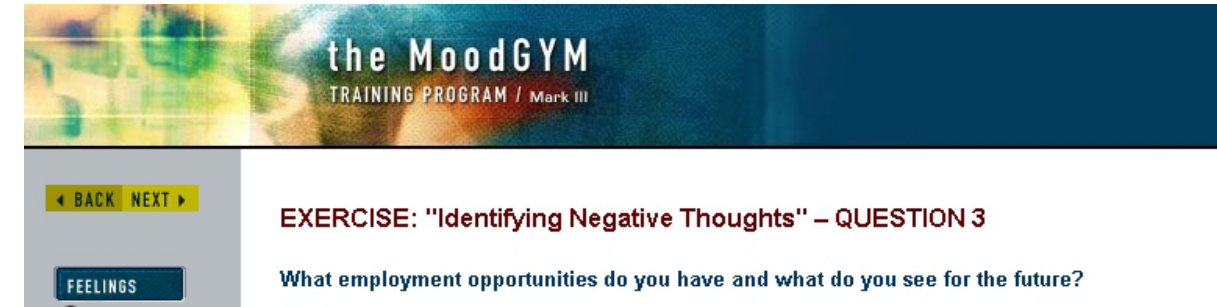
Figure 1. Example page from experimental